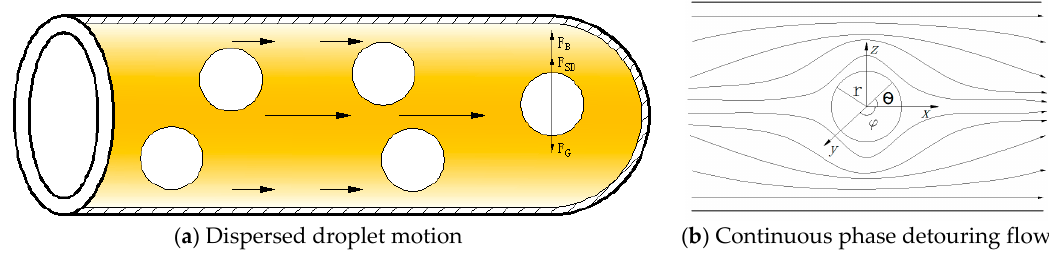
Figure 3. Schematic of forces on dispersed droplets in shearing fields.